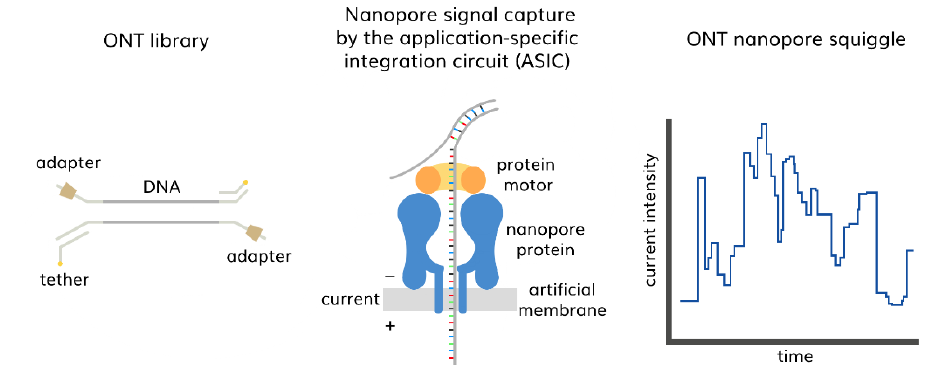
Figure 4. ONT’s library base calling in nanopore protein.